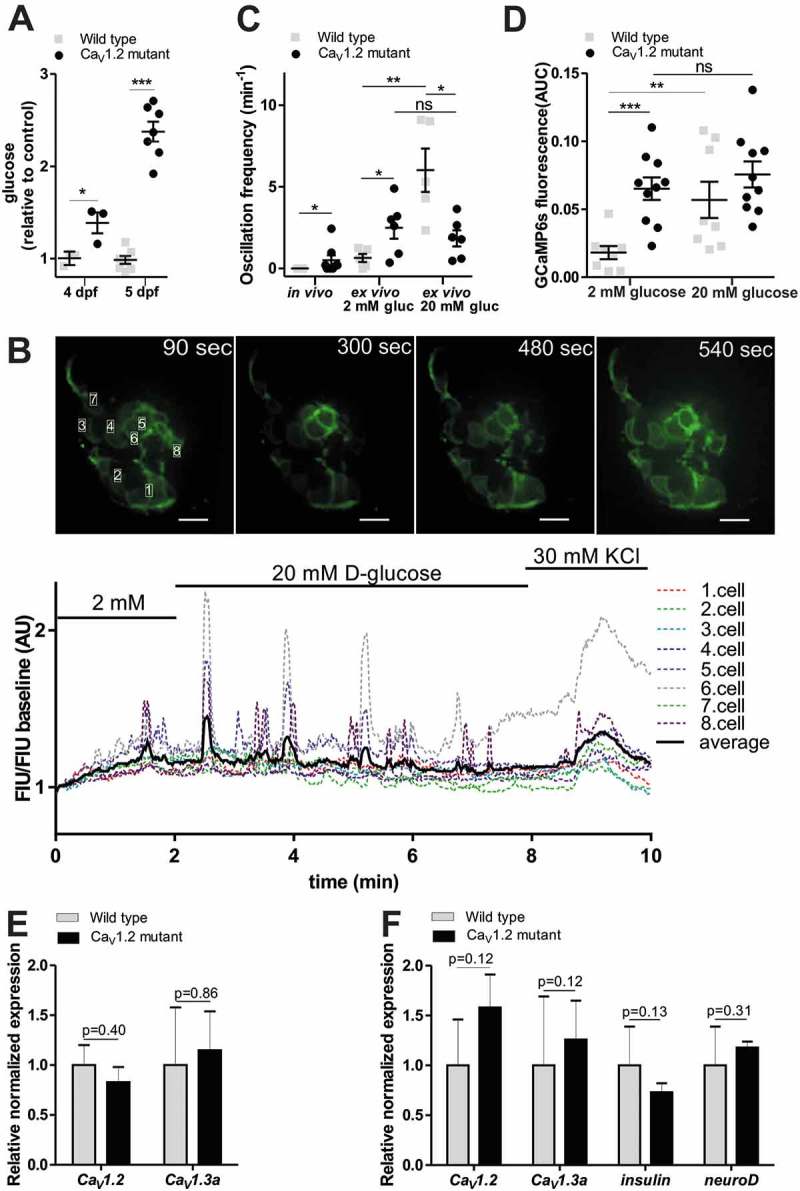
Ex vivo imaging of β-cells Ca2+i dynamics in CaV1.2 mutant zebrafish larvae.(A)
CaV1.2/islm458 mutant shows elevated whole larval glucose levels at 4 and 5 dpf. Glucose levels measured at 4 and 5 dpf whole larval extracts (pool of 10–10 larvae), normalized to the protein level measured by Nanodrop, and showed as relative to the average control value. (n = 4 and 8 biological replicates, respectively) (at 5 dpf, results combined from 2 independent experiments) (***p < 0.0001, two-tailed t-test). (B) Fluorescence image series of an isolated islet from 5 dpf old CaV1.2 mutant crossed with ins:lynGCaMP6s larva (upper panel). Quantitation of GCaMP signal intensity in the time series shown in the upper panel, indicating FIU/FIU baseline changes after 20 mM glucose as well as after 30 mM KCl stimulation (lower panel). (C) Quantification of GCaMP6s fluorescence intensity peaks determined by PeakCaller, MATLAB in vivo, without any stimulation (n = 6 wild type and 8 CaV1.2 mutant larva), and ex vivo, upon 2 and 20 mM glucose stimulation in wild-type and CaV1.2 mutant larva (n = 7–7 and 6–6 larvae, respectively), shown as oscillation frequency (min−1) (peak number/cell number*minute). β-cell number was defined based on red nuclei RFP expression in one focal plane (4–10 cells per islet were analyzed) (**p < 0.005, two-tailed, nonparametric Mann-Whitney test) (D) Quantification of GCaMP6s fluorescence intensity ex vivo in wild-type and CaV1.2 mutant larvae shown as area under curve (AUC) upon 2 mM and 20 mM glucose stimulation normalized to the treatment duration (n = 9 and 10 larvae, respectively) (***p < 0.0005, two-tailed, unpaired t-test). (E) Relative normalized CaV1.2 and CaV1.3a mRNA expression levels as determined by RT-qPCR (reverse transcriptase quantitative PCR) in 5 dpf old wild type and CaV1.2 mutant larvae (pools of 15 whole larvae) (n = 3 biological replicates, 2 technical replicates) (F) Relative normalized CaV1.2, CaV1.3a, insulin and neuroD mRNA expression levels determined by RT-qPCR in isolated pancreatic islets from 5 dpf old wild type and CaV1.2 mutant larva (pools of 15 islets) (n = 3 biological replicates, 2 technical replicates). Data are shown as mean values ±s.e.m (*p < 0.05, two-tailed t-test). FIU = Fluorescence Intensity Units (AU, Arbitrary Units).